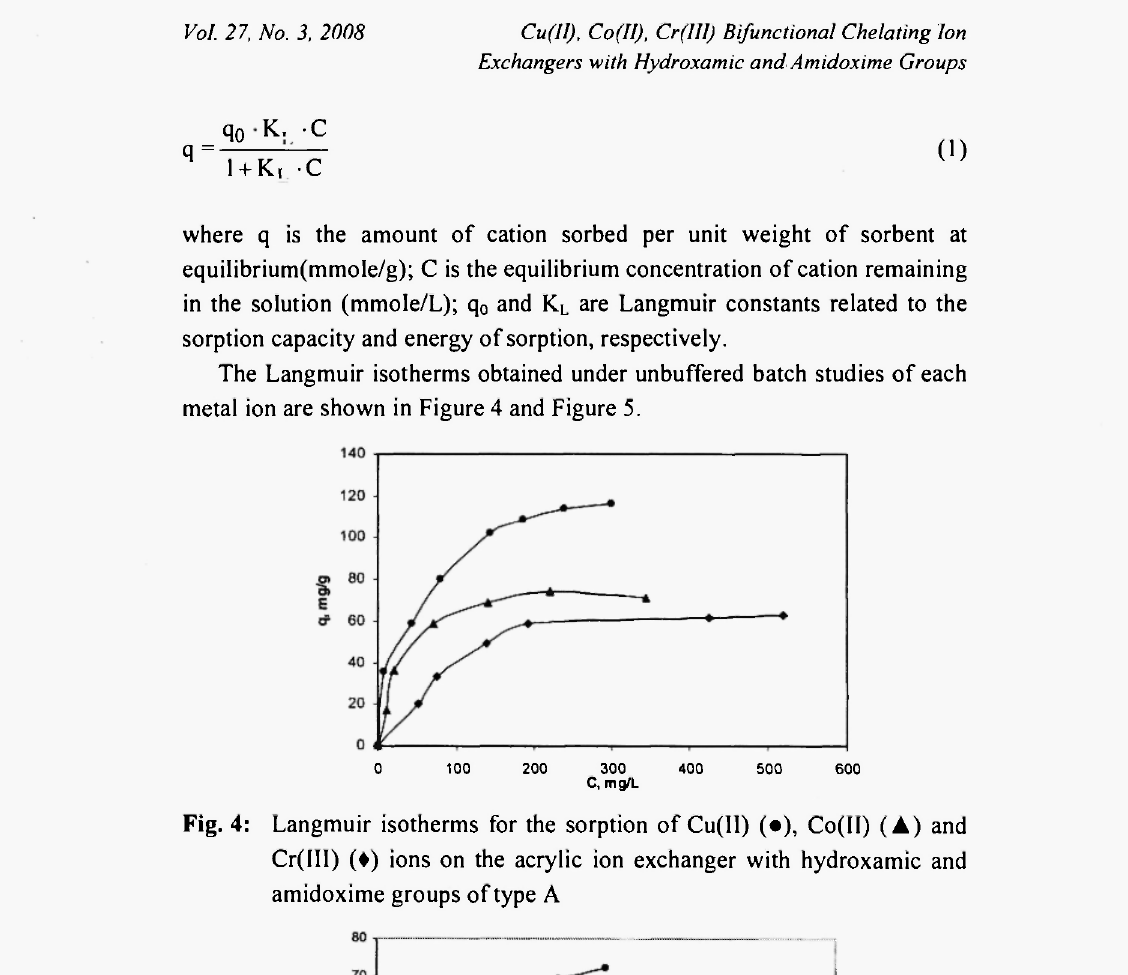
Langmuir isotherms for the sorption of Cu(ll) (·), Co (II) ( A) and Cr(Ill) (•) ions on the acrylic ion exchanger with hydroxamic and amidoxime groups of type A